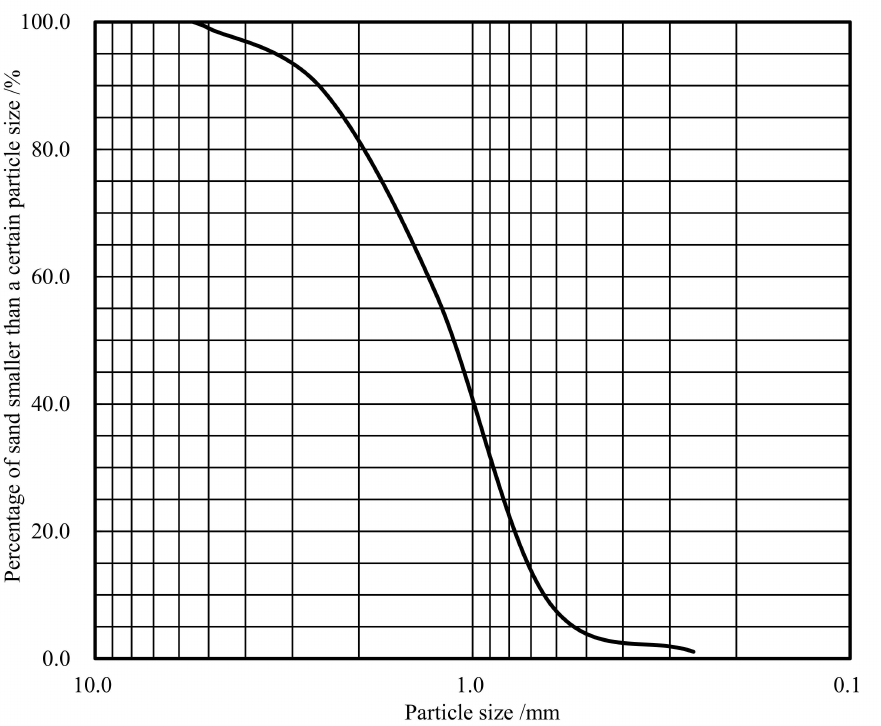
Figure 2. According to ASTM standard D6913 / D6913M-17 [37], the collected sand is defined as coarse